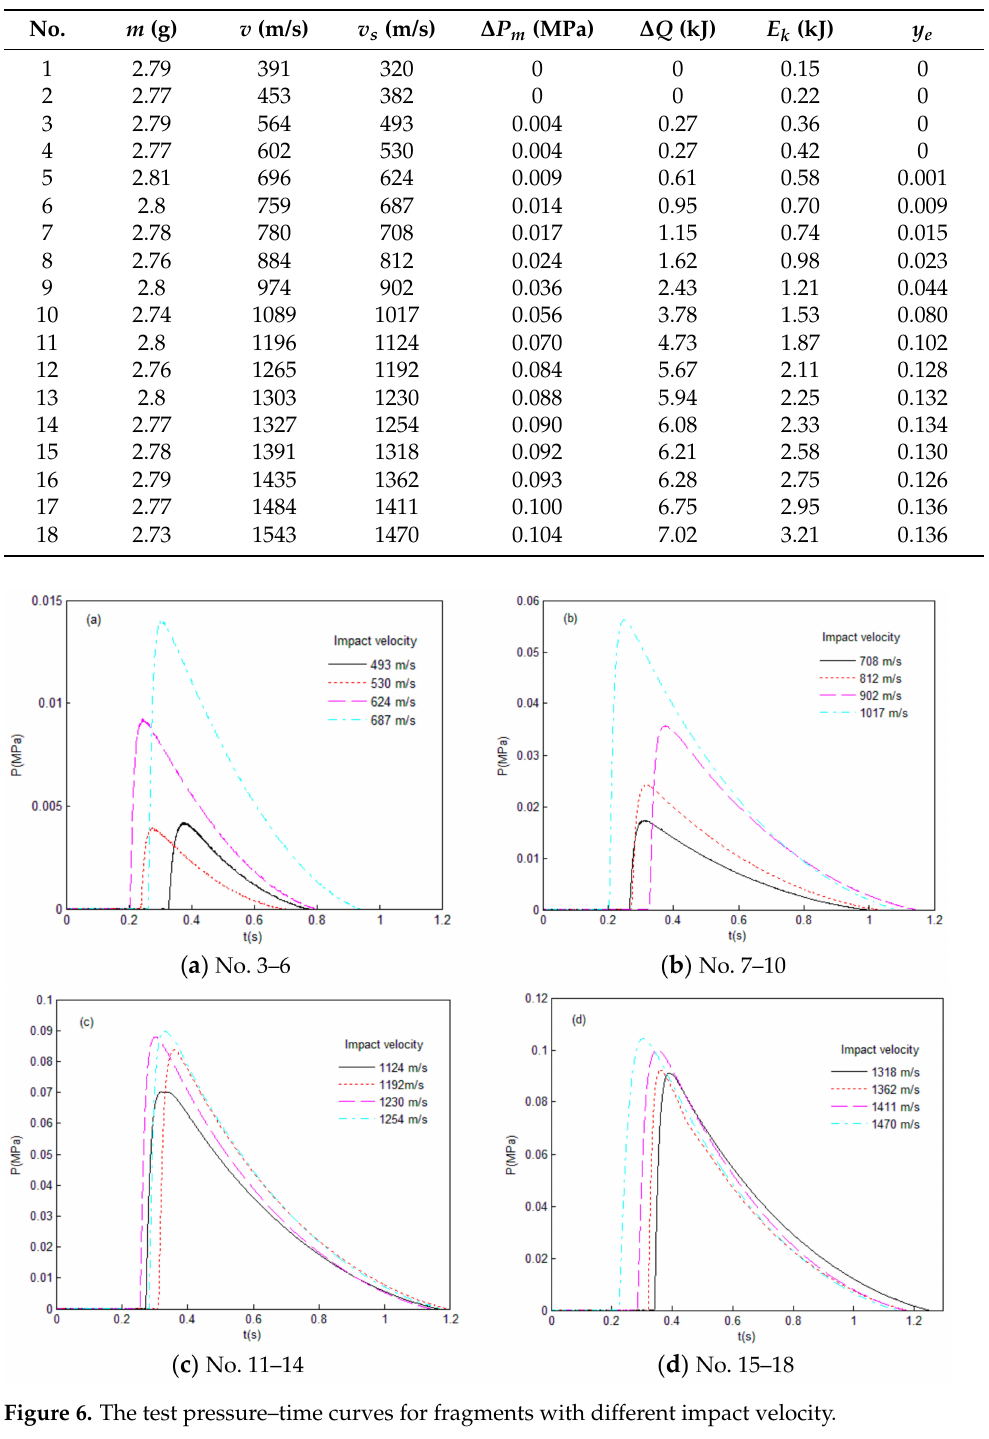
Table 2. Fragment penetration test result.